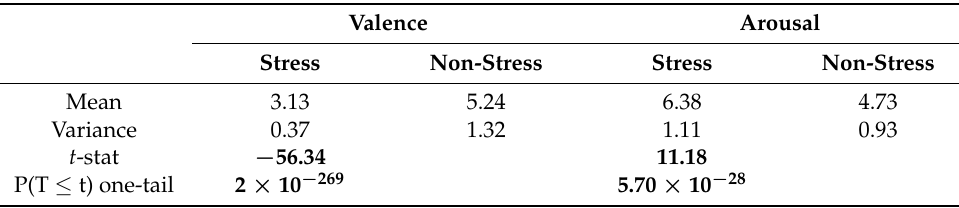
Table 5. The t -test evaluated valence and arousal values in the stress and non-stress groups.